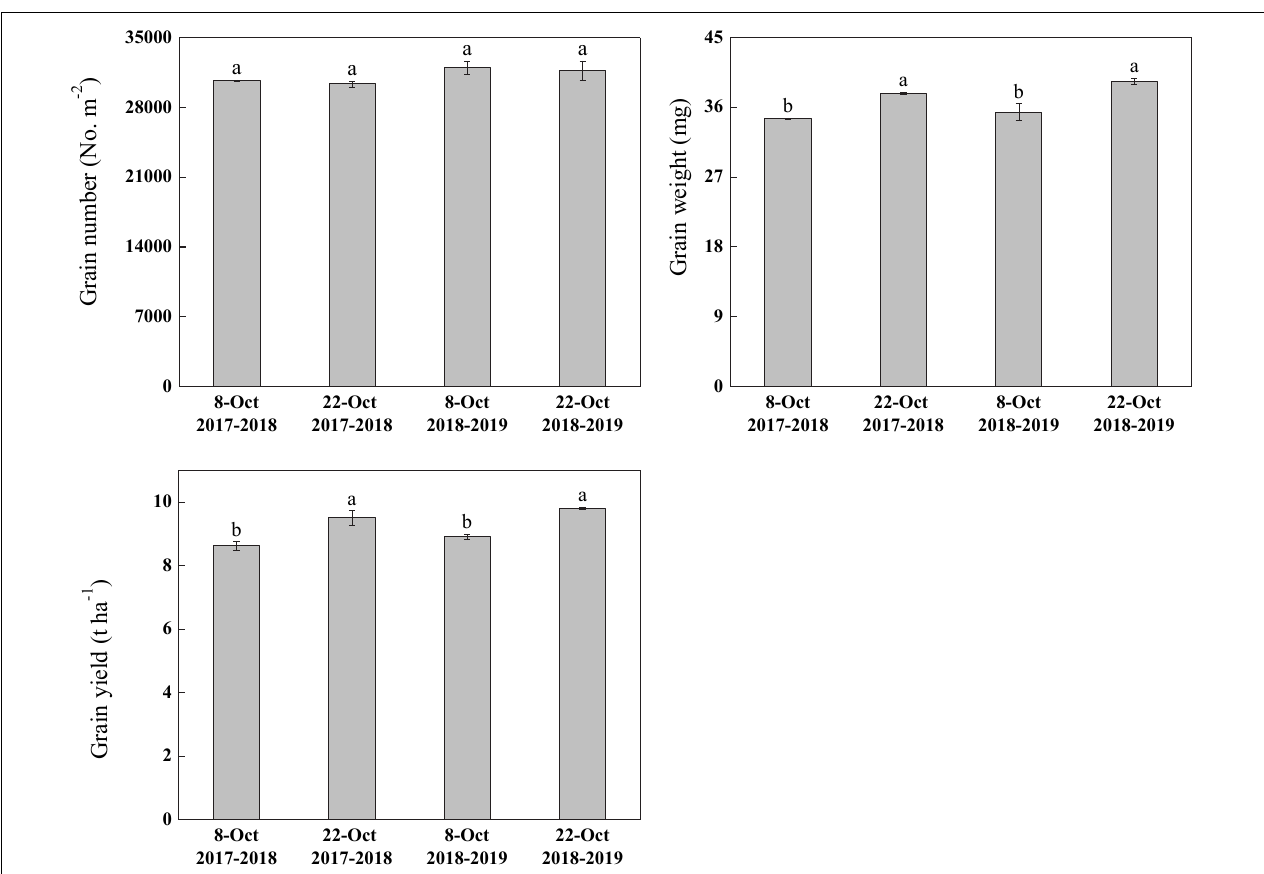
FIGURE 2 | Effect of delayed sowing on grain number, grain weight, and grain yield of wheat under heat stress at late grain–filling stage. Values are means of three replicates per treatment. Vertical bars indicate standard error. Different letters denote statistical differences by LSD test ( P < 0.05) between treatments for each parameter in the same